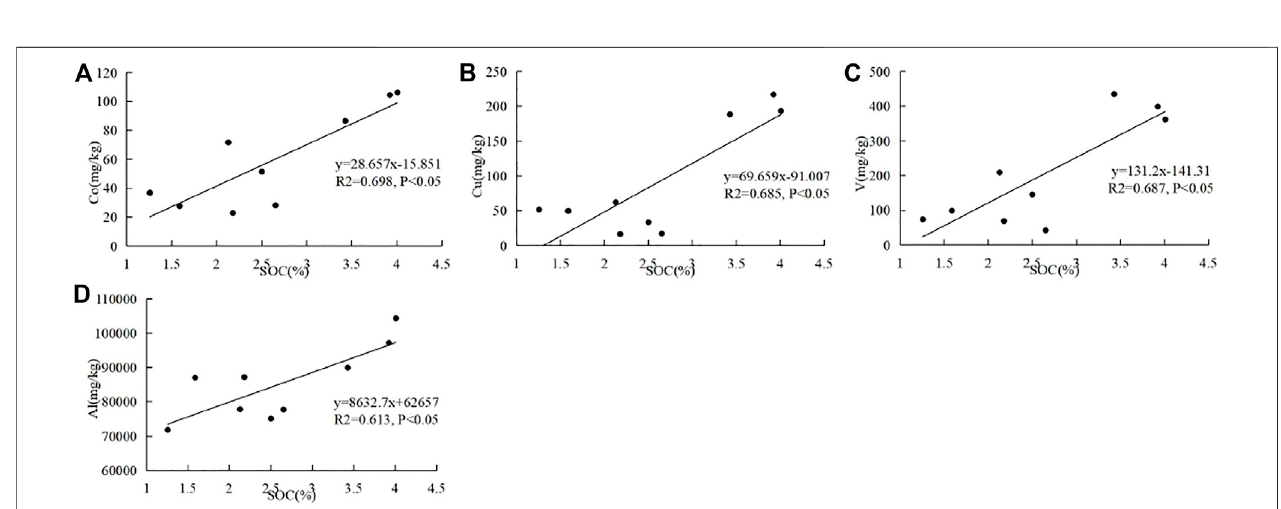
FIGURE 4 | Correlations of SOC with Co (A) , Cu (B) , Ti (C) , V (D) , Zn (E) , Ni (F) , Ca (G) , and P (H) in the mineral horizon.